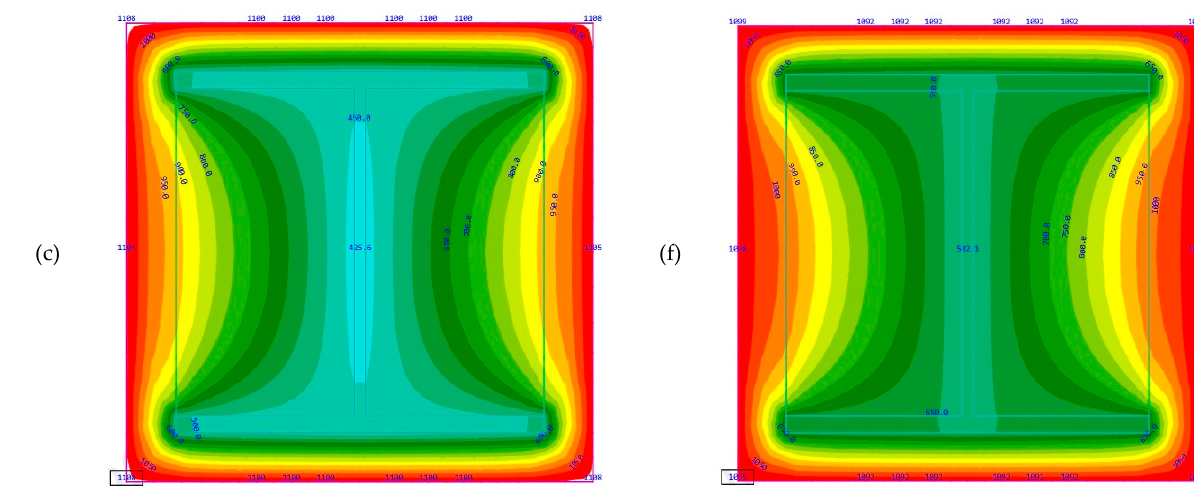
Figure 9. Temperature distribution through the cross section by the 90th, the 120th, and the 180th minute of fire impact in a standard fire case and in a hydrocarbon fire case (standard fire, 90, 120, and 180 min (subfigures a – c ); hydrocarbon fire, 90, 120, 180 min (subfigures d – f )).